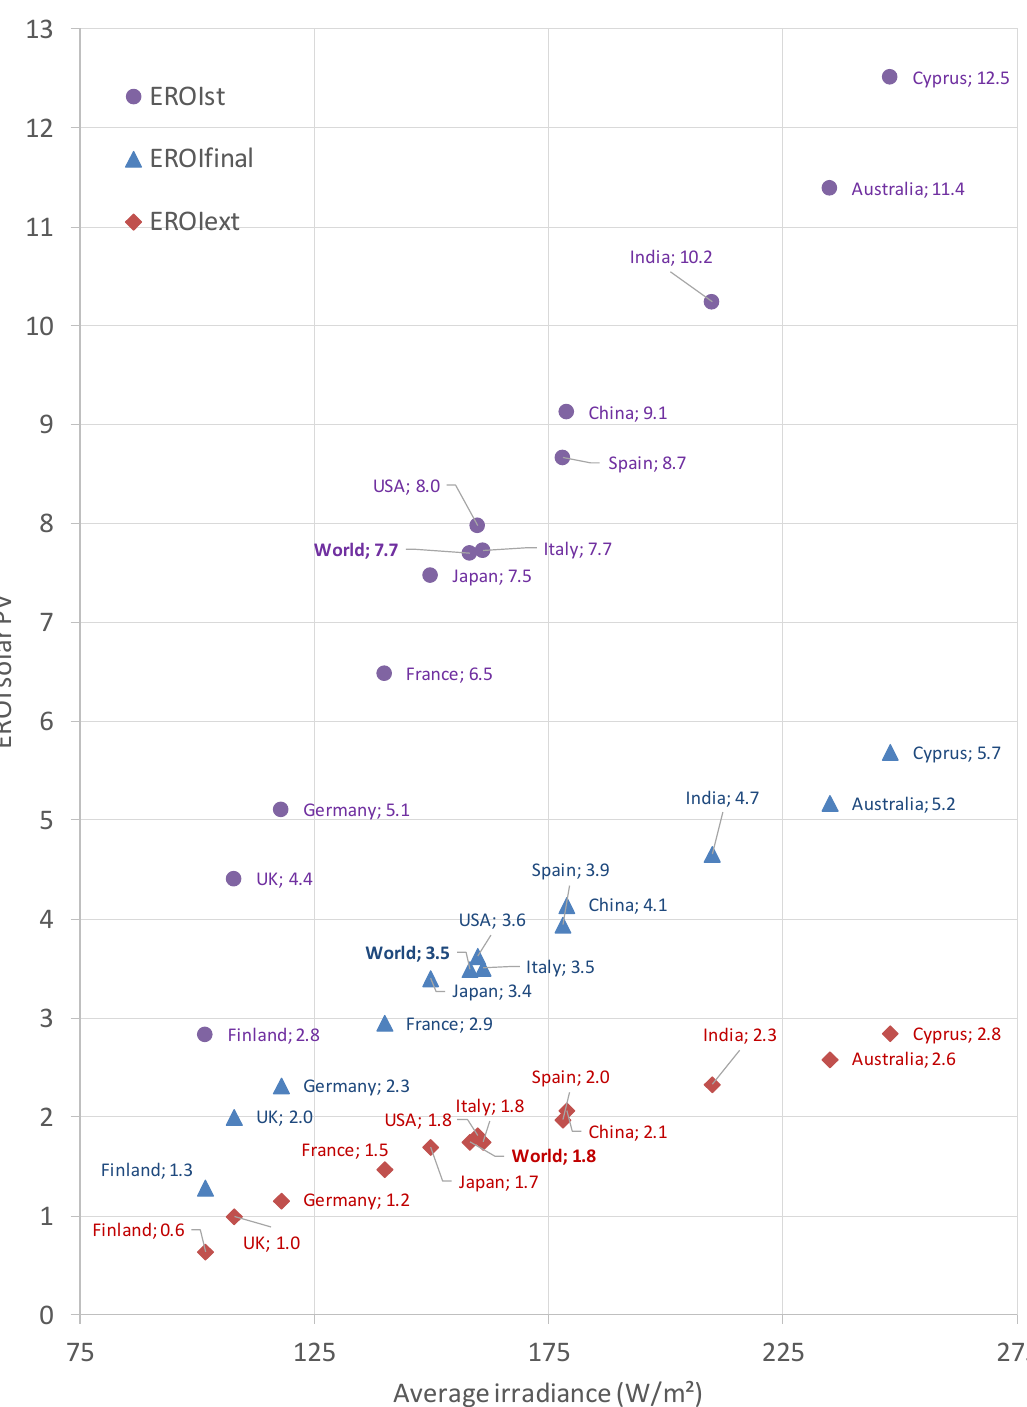
Figure 5. EROI levels at standard (EROI st ), final (EROI final ), and extended (EROI ext ) stages of PV solar on land for the top 10 countries with more installed capacity, the global average, and Finland and Cyprus as holders of the minimum and maximum irradiance at European Union (EU) level. The current weighted global average for solar irradiance where power plants are installed is found to be ~160 W/m 2 .